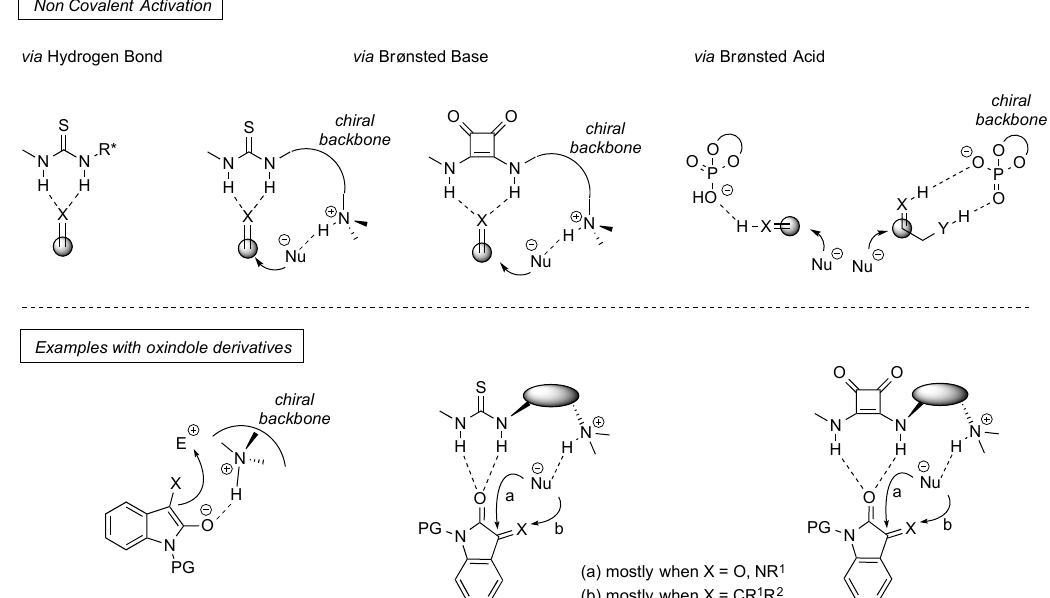
Figure 2. Examples of non-covalent interactions in a substrate/reagent/catalyst system.